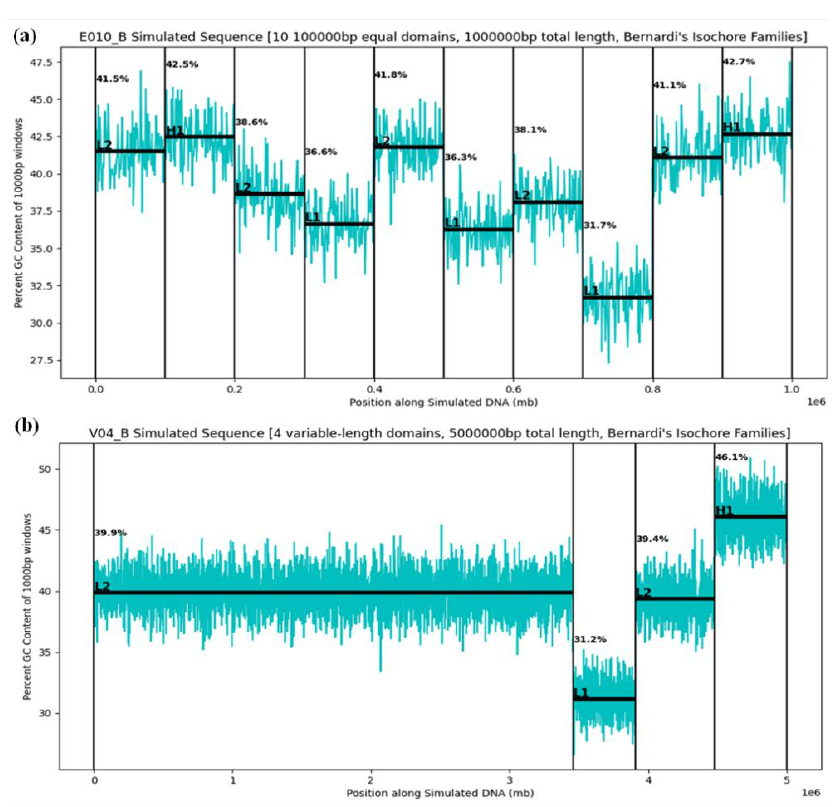
Figure 5. The GC content profiles of ( a ) a 1 Mb simulated sequence with ten equal-length domains and ( b ) a 5 Mb simulated sequence with four variable-length domains. Isochore family and mean GC percentage are indicated for each simulated